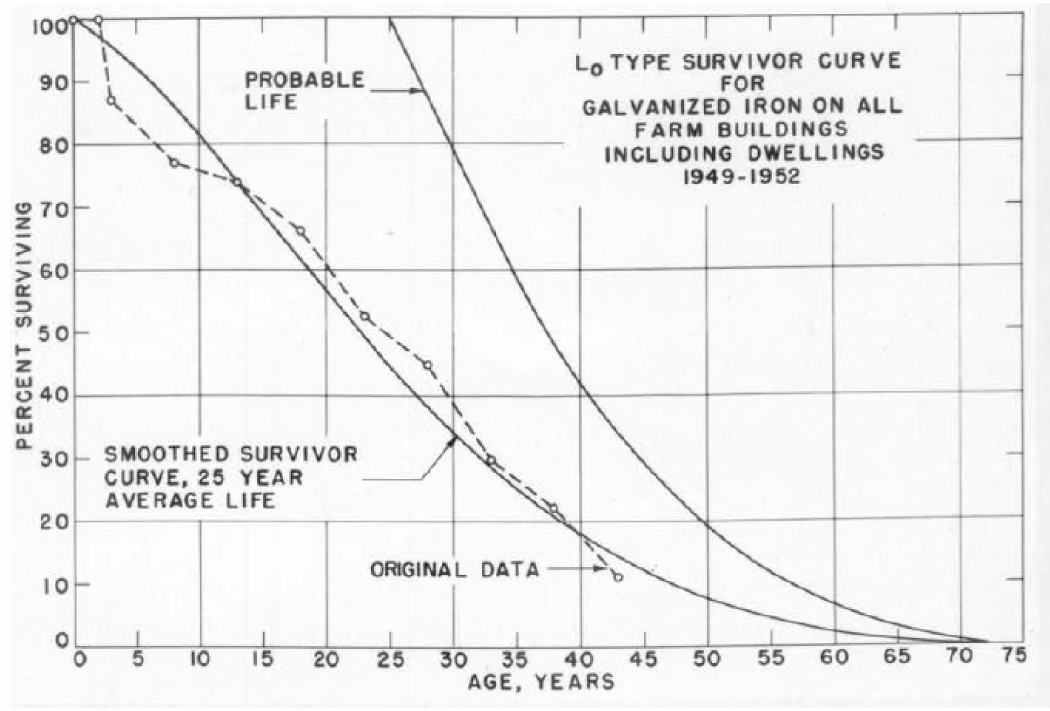
Figure 2. Survival rate of galvanized steel sheets